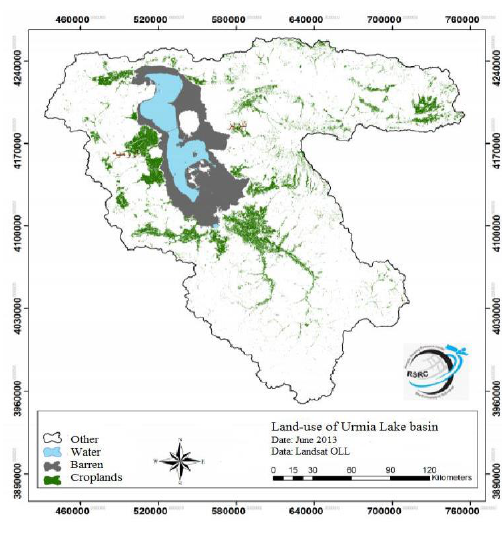
Figure 1: Land Use in the Lake Urmia Basin, 1976 vs Land Use in the Lake Urmia Basin in 2013, Showing an Increase of 30 percent in the Area of Agricultural Land in the Period